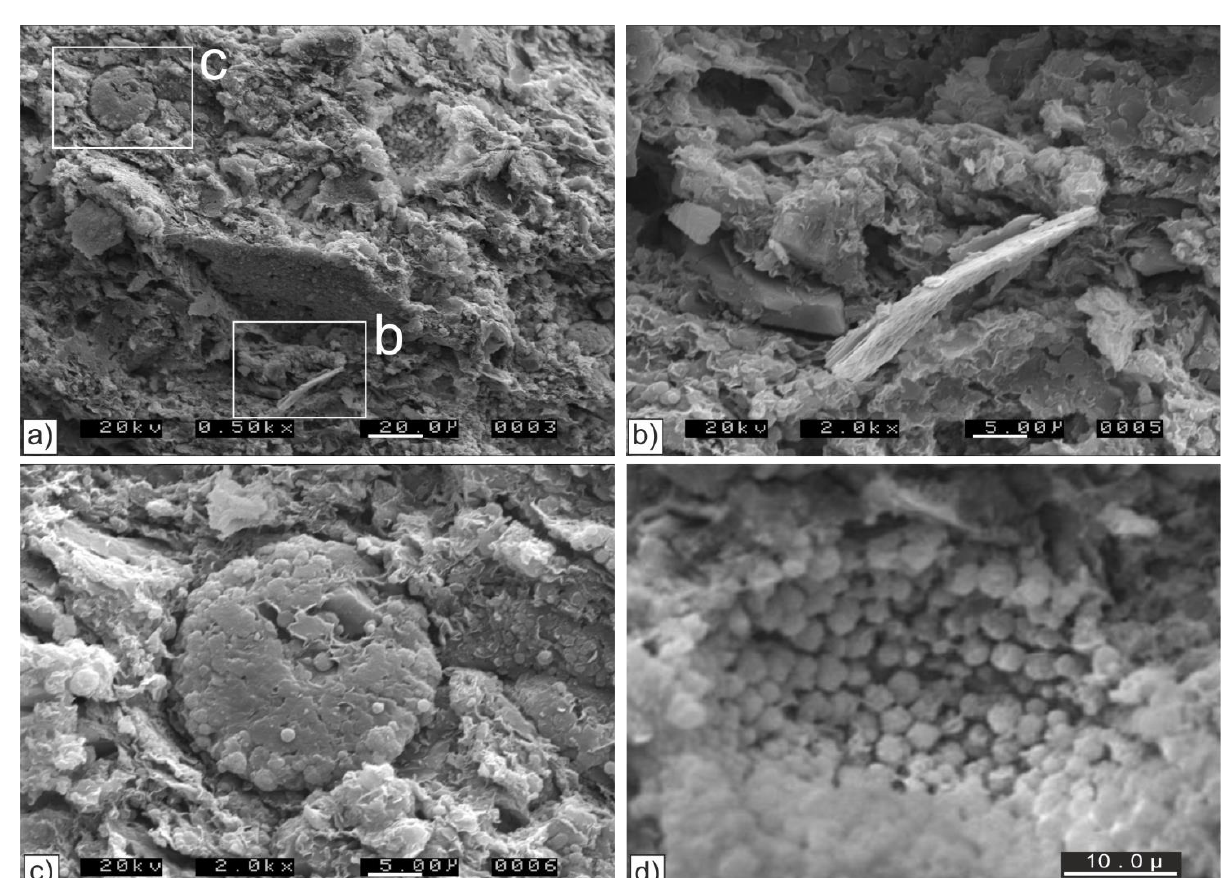
Figure 7. Scanning electron microscopy ( SEM) images of the bio siliceous mudstone sample (TH-01) from the Upper Kreyenhagen, Monocline Ridge (TGIC, Figure 3b). The sample is consolidated. ( a ) Crushed parts of a large diatom test in which the pristine opal A micro-texture is preserved. The surrounding bio silicious groundmass is largely comminuted fragments from crushed diatom shells; scale bar = 19.6 μm. ( b ) Micro-porous test fragments (opal A) in a groundmass of crushed tests; scale bar = 10 μm.